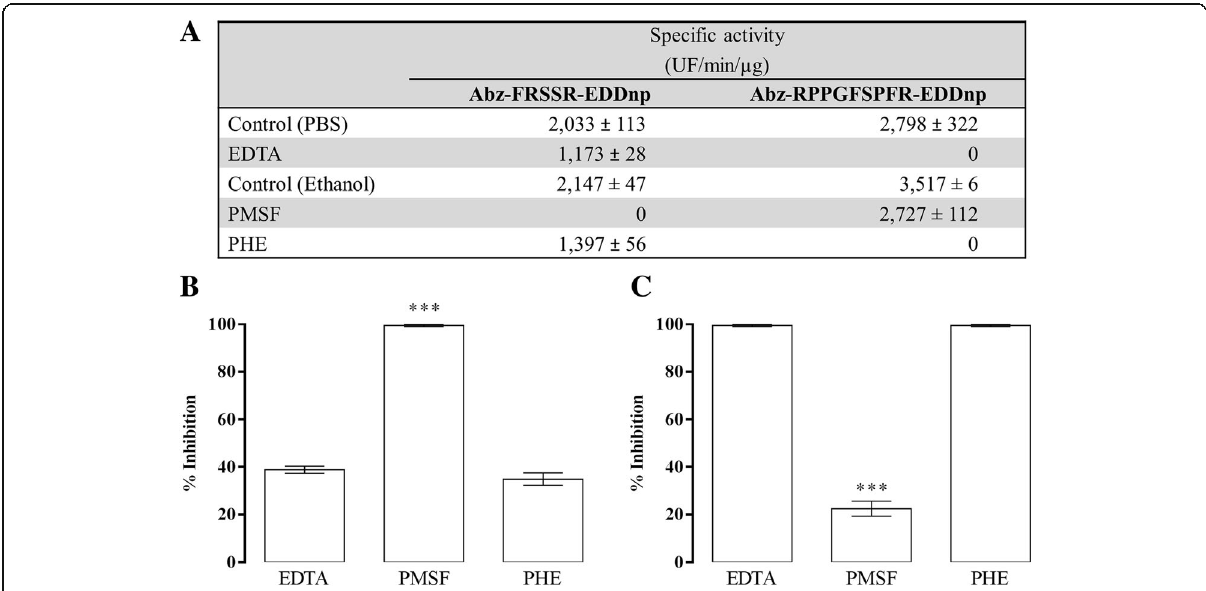
Fig. 1 Venom proteolytic activity. a The proteolytic activity of venom, pretreated or not with EDTA (100mM), PMSF (2mM) and PHE (2mM), was accessed by the hydrolysis of 10 μ M of Abz-FRSSR-EDDnp and Abz-RPPGFSPFR-EDDnp FRETs substrates. The percentage of inhibition upon ( b ) Abz- FRSSR-EDDnp and ( c ) Abz-RPPGFSPFR-EDDnp substrates was determined. These assays were performed in quadruplicate. Results were expressed as specific activity (UF/min/ μ g of venom)±SEM and analyzed statistically using One-Way ANOVA test followed by Tukey HSD post-hoc tests (* p <0.05)